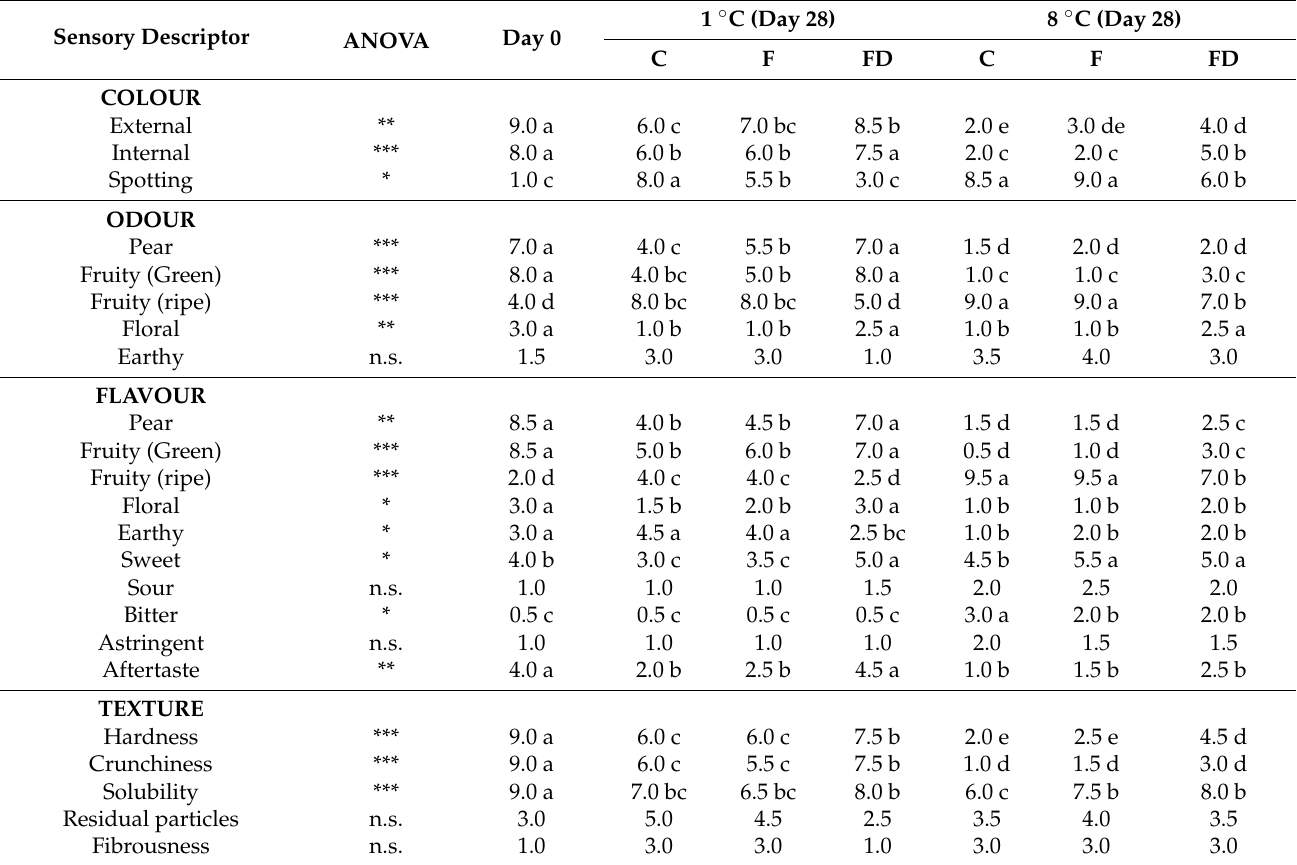
Table 4. Descriptive sensory analysis of pears. Number of panellists: 10. n =